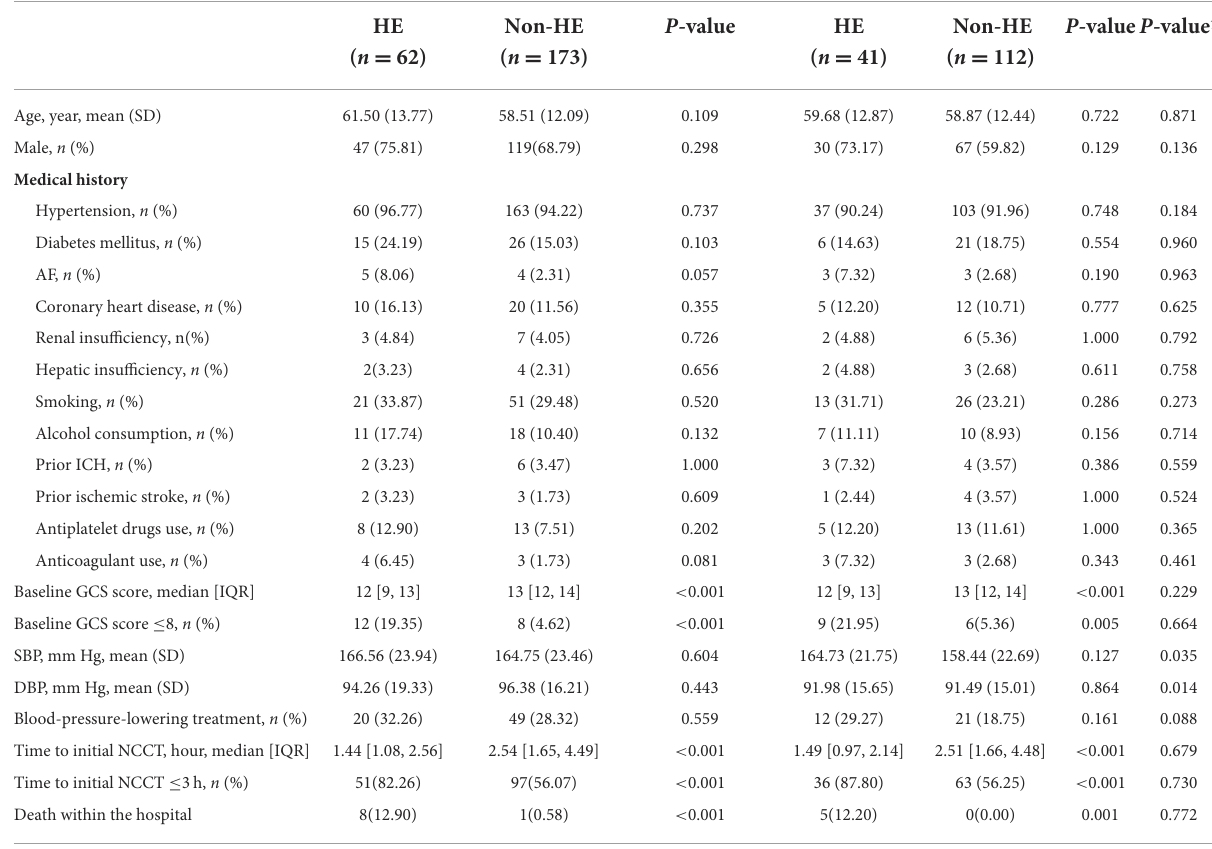
TABLE 1 Demographic and clinical characteristics of patients with and without HE.